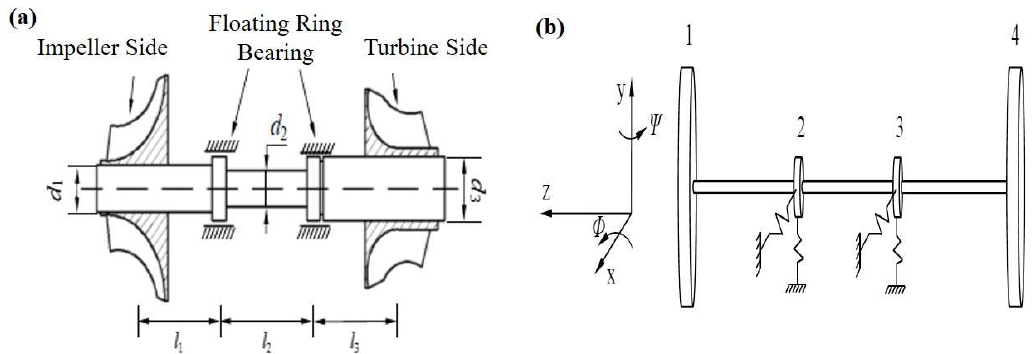
Figure 1. ( a ) Schematic diagram of the turbocharger rotor-bearing system. ( b ) Mechanical model of a turbocharger rotor-bearing system.